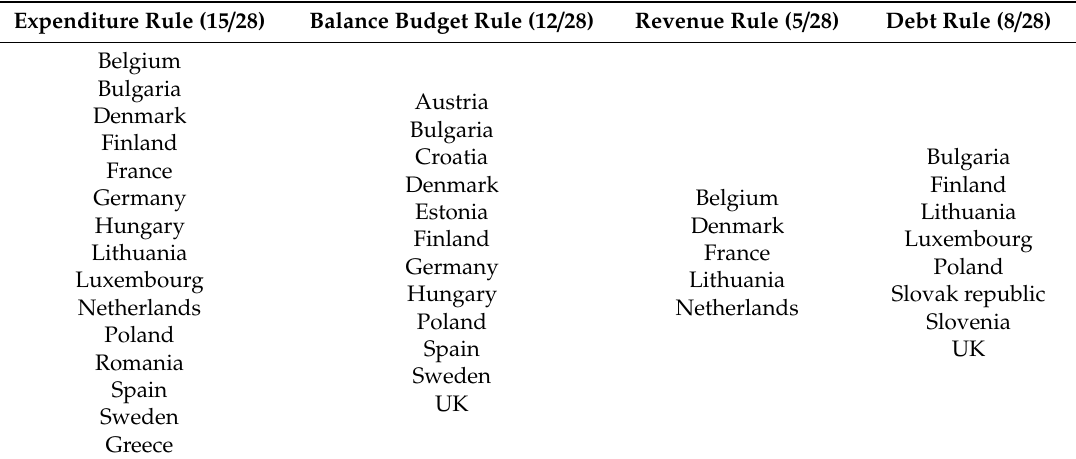
Table 1. Countries that have implemented specific fiscal rules during the sample period 2000–2015 (at least one